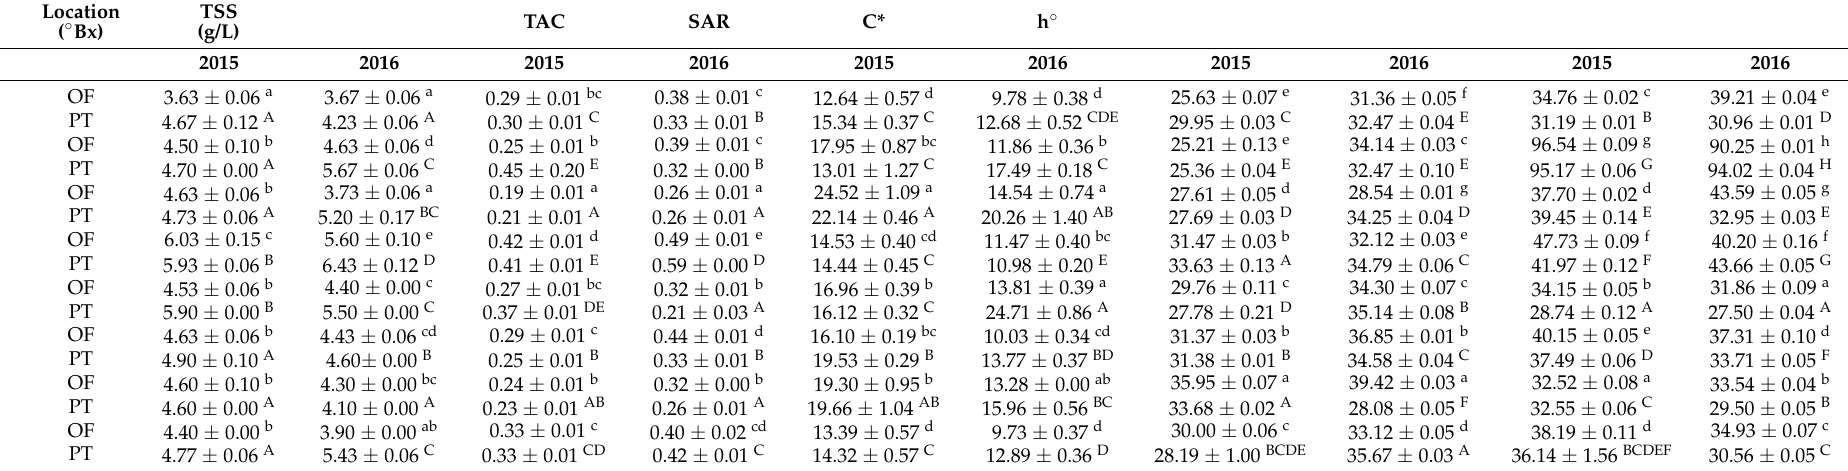
Legend: TSS: total soluble solids, TAC: titratable acid content, SAR: sugar-acid ratio, C*: chroma value, ho: hue value, OF: open field, PT: polytunnel, B: “Balatonbogl á r“, C: “ Cegl é d“, F: “ Fadd“, MR: “M á riap ó cs“, MT: “ M á trafüred“, SA: “ San Marzano“, TA: “ Tarnam é ra“, TO: “ Tolna“. Data highlighted with grey are significantly higher in the comparison of locations within a year; data in bold are significantly higher in the comparison of years within a location. Different lower- and upper-case superscript letters within columns are for significant differences among PGRs in an open field and in a polytunnel, respectively (Games–Howell, p <